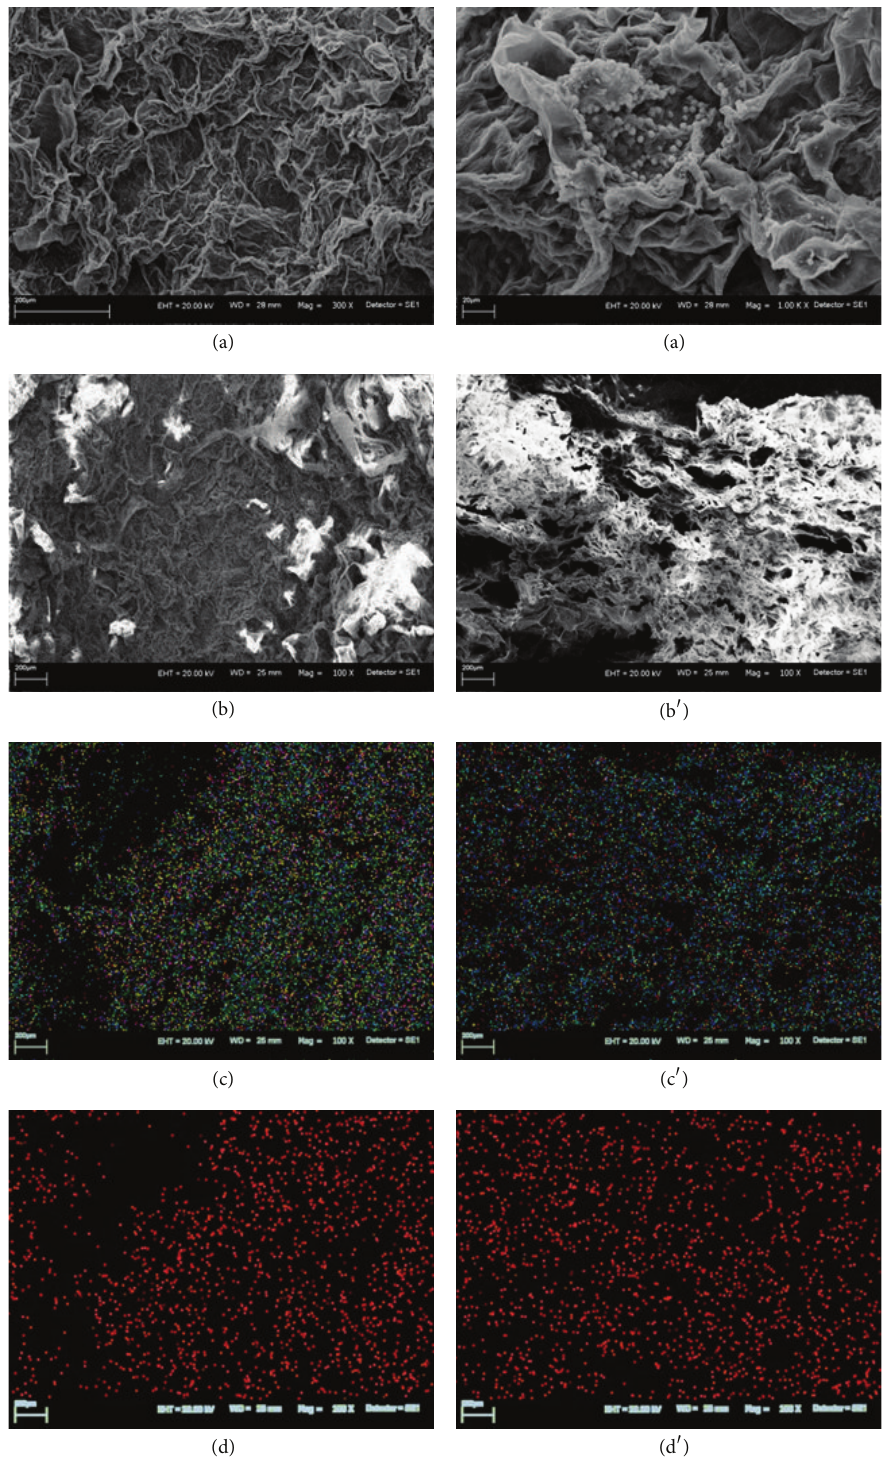
Figure 3: (a) A picture of the surface of Vaucheria sessilis enriched with Cu(II) ions; bottom picture of surface (b) and cross section (b 󸀠 ) of macroalga; mapping of all elements on the surface (c) and in the cross section (c 󸀠 ); mapping of Cu(II) ions on the surface (d) and in the cross section (d 󸀠 ) (C—green, O—dark blue, Na—bright blue, Al—yellow, P—pink, Cu—red, and